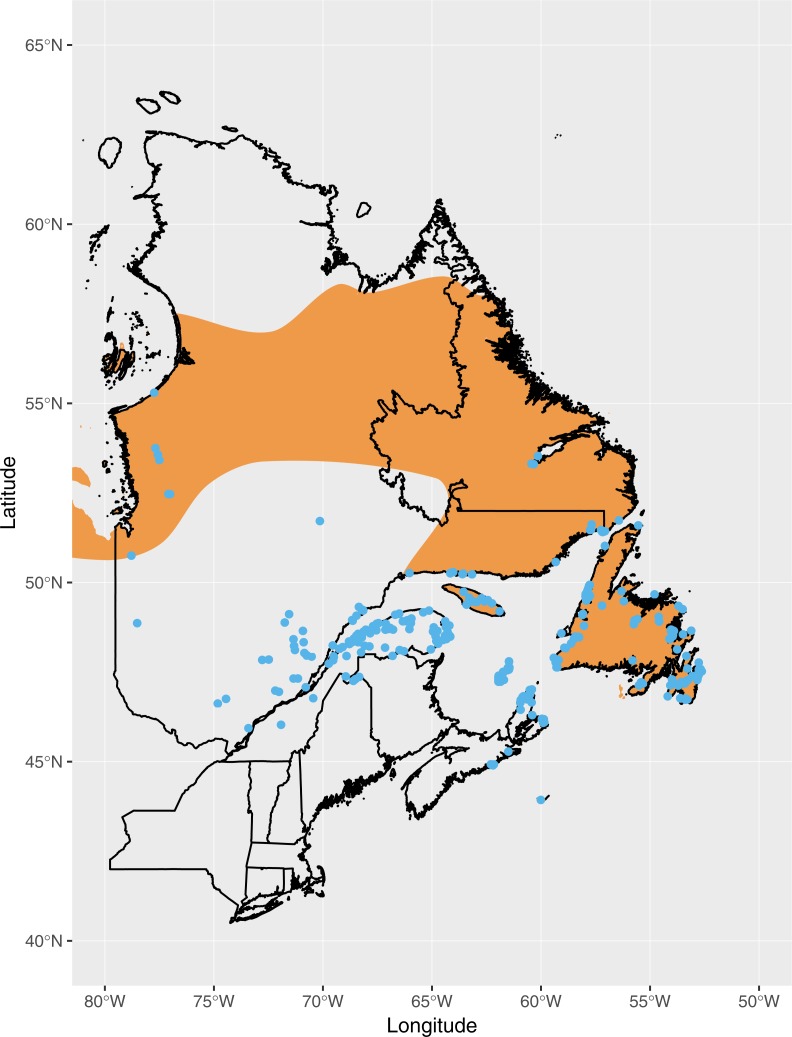
Observations of Fox Sparrow during June and July in eastern Canada reported to eBird as of July 1990 (blue points), the approximate point at which observations of Fox Sparrows during the summer began increasing in Maine.The putative breeding range of Fox Sparrow according to BirdLife International and NatureServe (2014) is shown in orange.